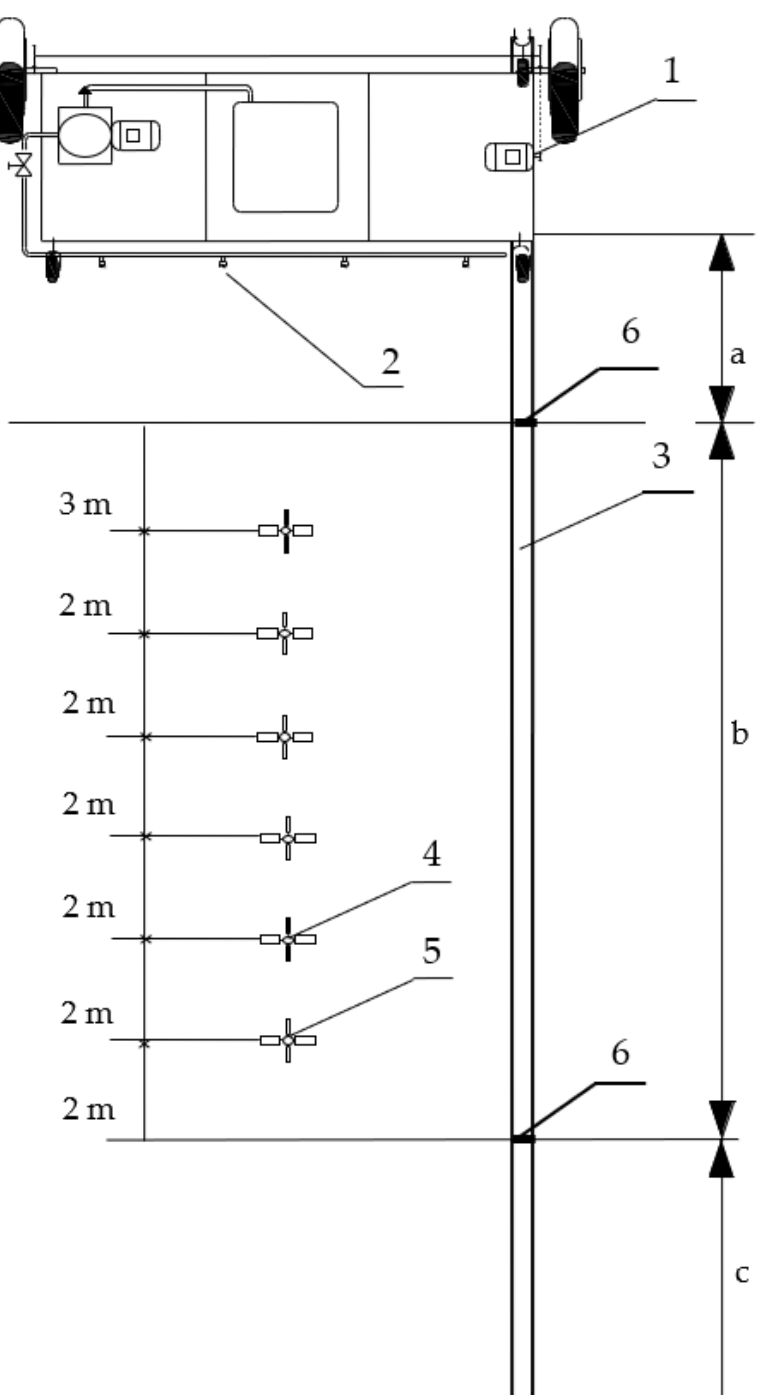
Figure 1. General view of measurement stand: a—inrun section, b—measurement section, c—final section, 1—sprayer, 2—nozzle, 3—guideway, 4—an artificial plant with filter paper, 5—an artificial plant with water-sensitive paper, 6—limit